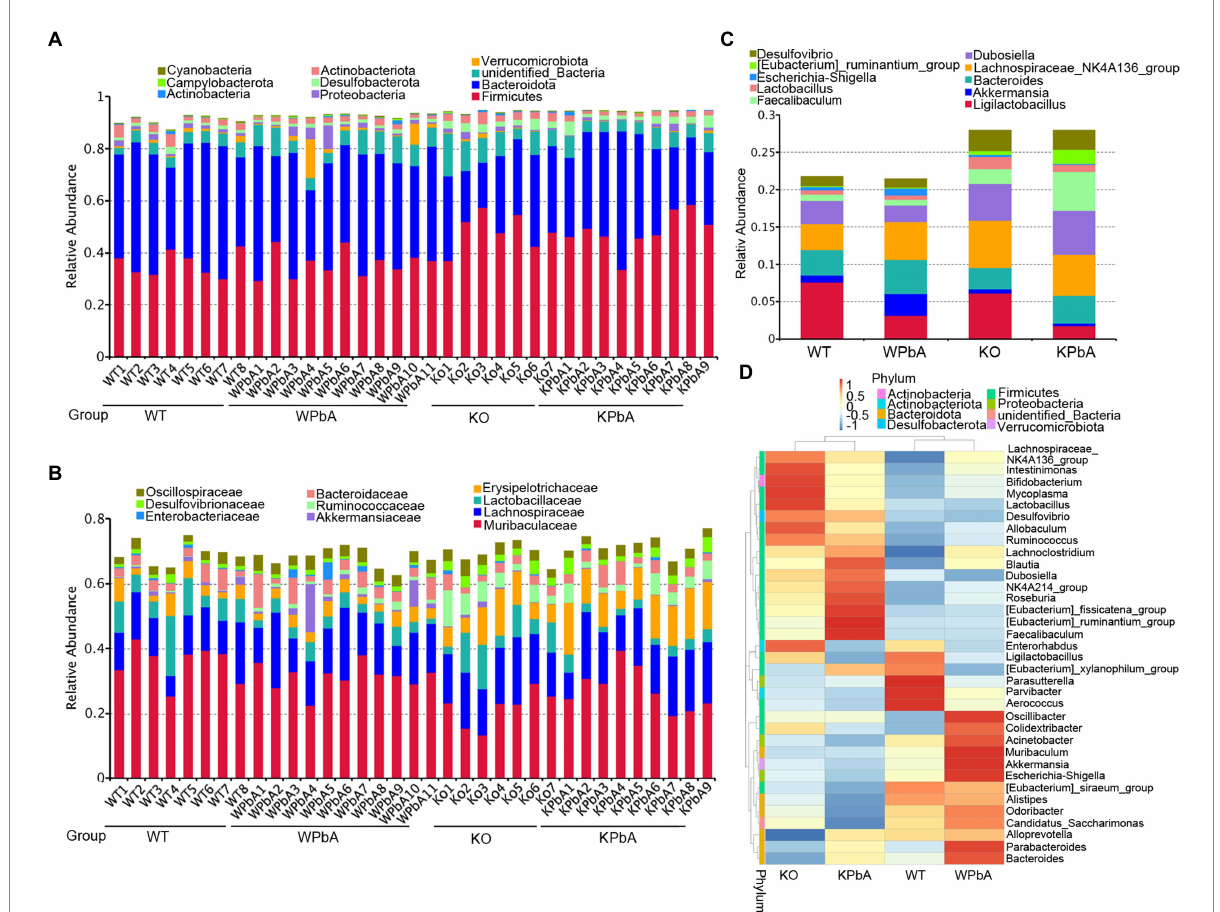
FIGURE 2 Variation in microbial community components at different taxonomic levels. (A) Proportions of bacterial communities at the phylum level. (B) Proportions of bacterial communities at the family level. (C) Proportions of bacterial communities at the genus level. Each column represents the constitution and proportion of the top 10 most abundant microbial communities in each individual or group. (D) Taxonomic heatmap of the top 35 most abundant microbial communities at the genus level. The left pattern represents the clustering trees at the genus level. The above profile displays clustering trees among different